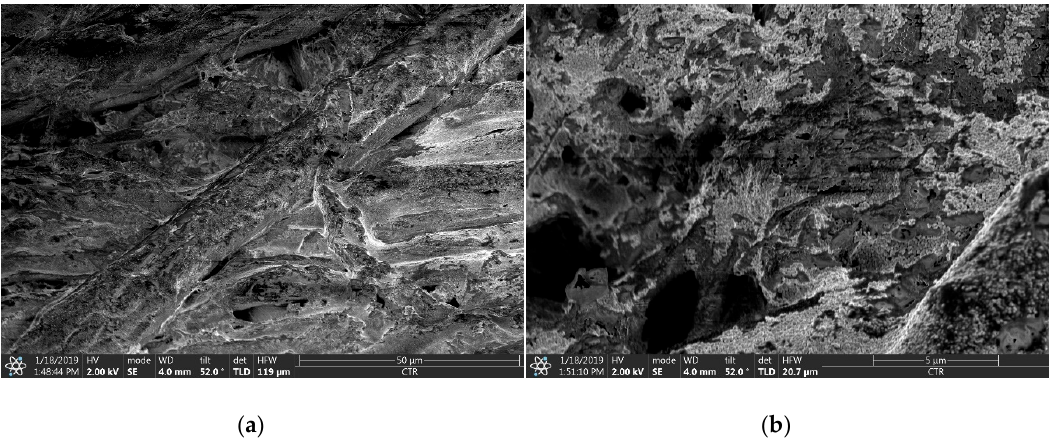
Figure 8. SEM images of the printed, cured and sintered Ag-layers on type 7 paper substrate; the size bars are 50 µm ( a ) and 5 µm ( b ) in length, respectively.